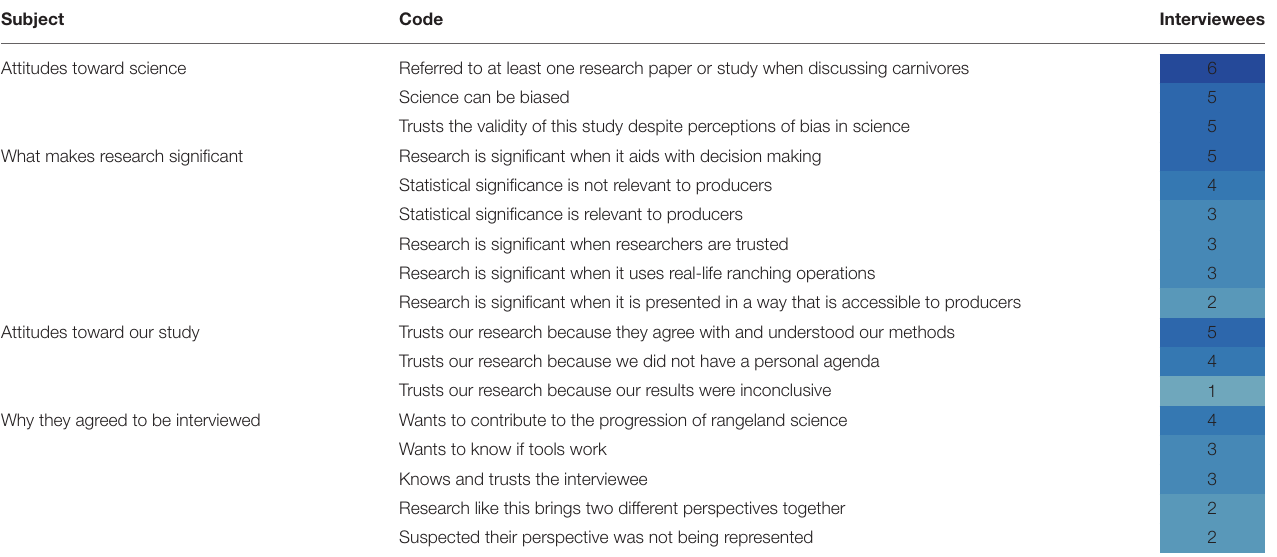
TABLE 5 | Attitudes toward science and our